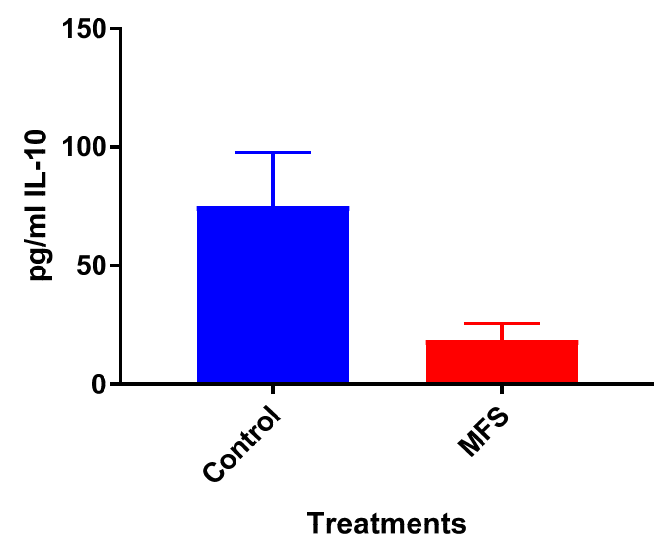
Figure 4. Levels of IL-10 in untreated and MFS-treated THP-1 cells. Assay of IL-10 was performed using an enzyme-linked immunosorbent assay (ELISA) Ready-Set-Go kit from eBioscience. Data represent means ± SE from 6 trials.